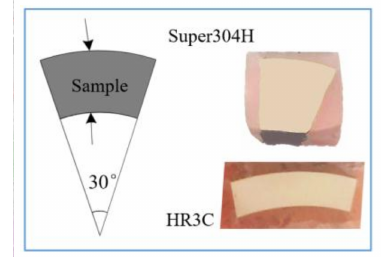
Figure 2. Schematic diagram of cutting samples.